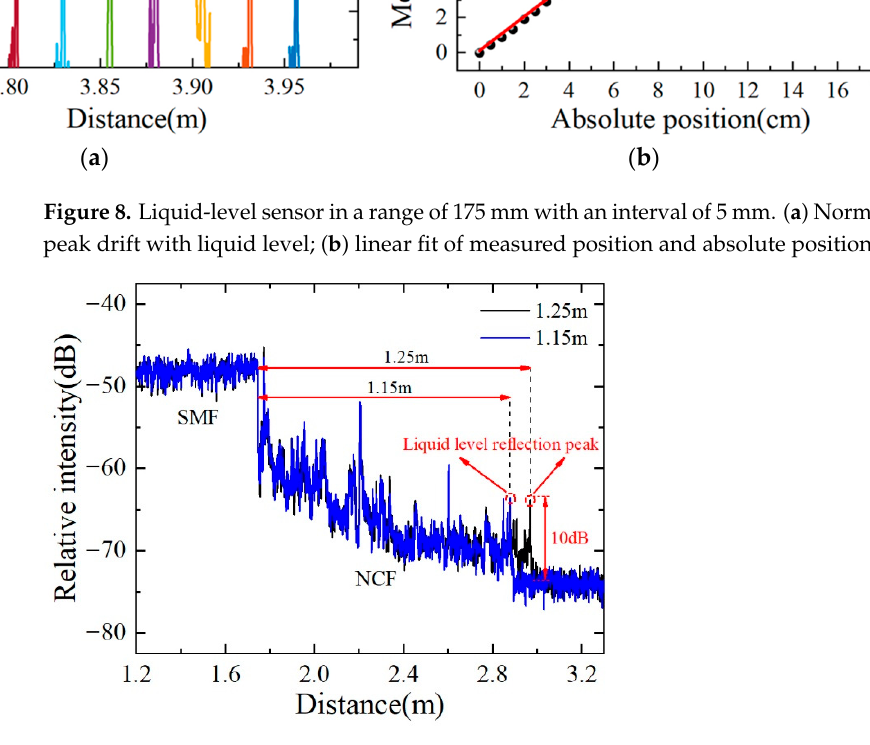
Figure 10. Liquid-level sensor in a range of 2 mm with an interval of 0.1 mm. ( a ) Normalized reflec- tion peak drift with liquid level; ( b ) linear fit of measured position and absolute position of liquid level. The peak value of the reflection peak on the distance domain is extracted as the liquid level (measurement distance), measurement position, and absolute position (step distance controlled by the electric lift) are linearly fitted. The result is shown in Figure 10b: the slope of the fitting curve is 0.9905, and the R 2 value is 99.89%, indicating that there is a highly linear relationship between the measured position and the absolute position. To verify the stability of the sensor, a repeated experiment was designed at the same liquid level. Figure 11a shows several typical scattering signals in the distance domain. Figure 11b shows 120 groups of liquid-level data points, collected every 30 s for a total of 60 min. It is found that all scattering curves almost overlap together, and the strong re- flection peaks fluctuate within a very tiny range. Slight changes may occur over time due